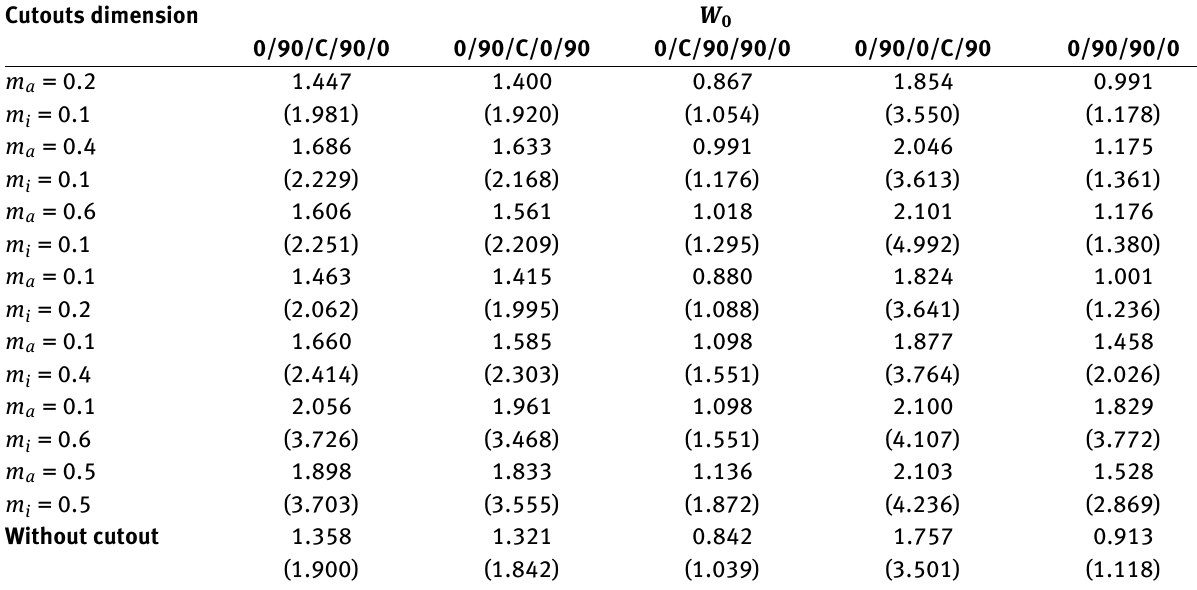
Table 3: Variation of transverse central deflection of simply supported (S2) LCSP and composite plate with stacking sequences and cutouts dimensions